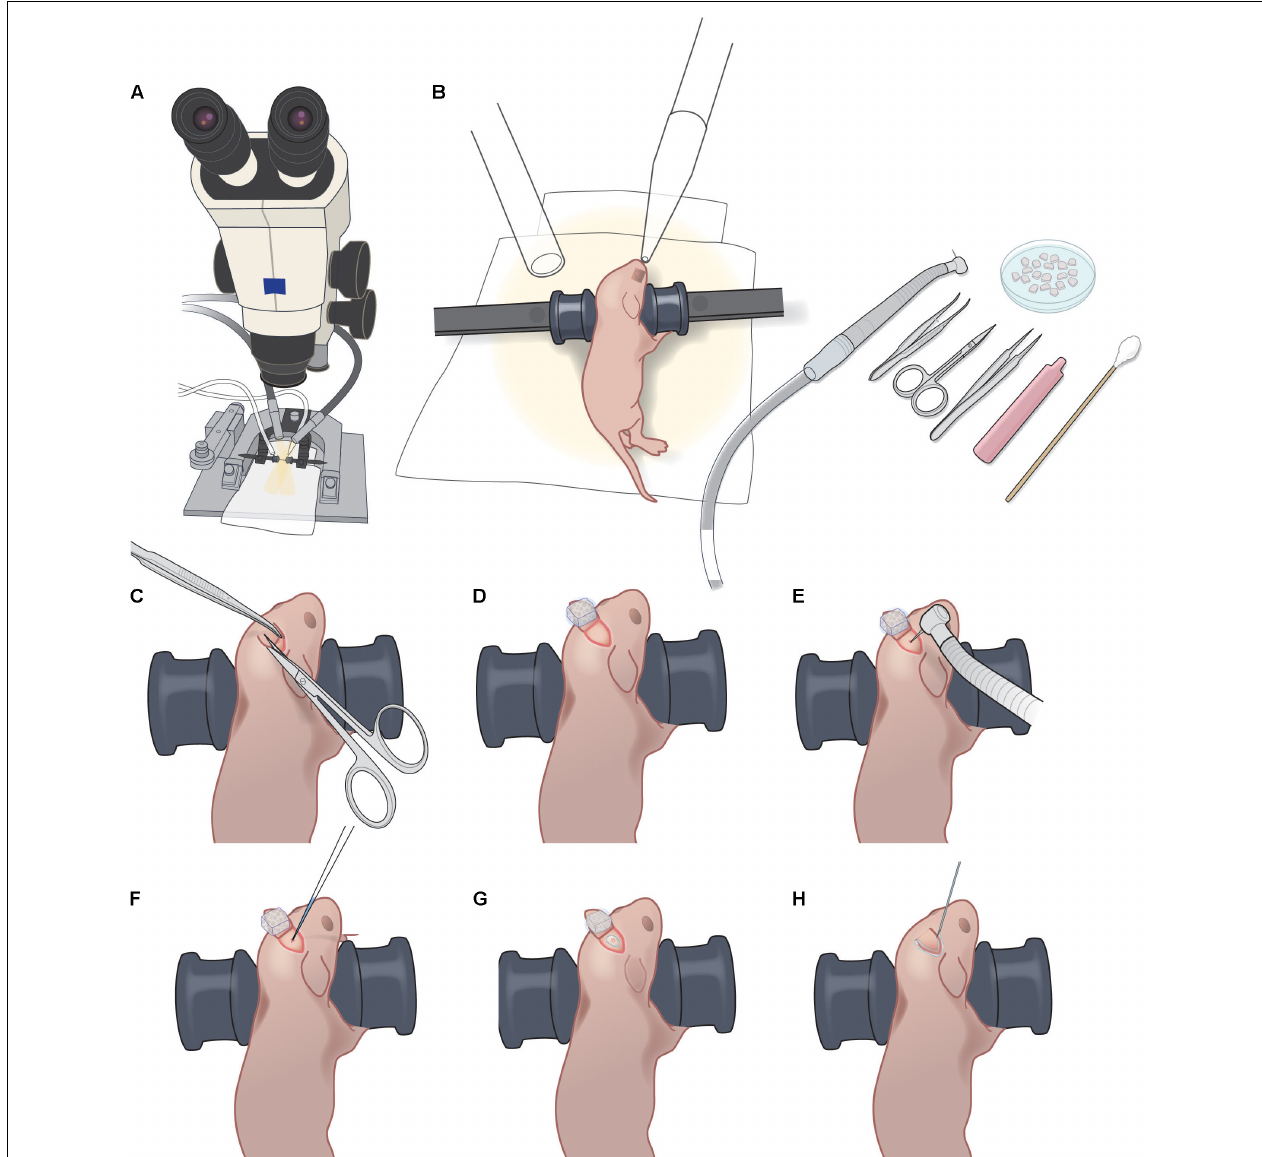
FIGURE 1 | P1 injection setup and procedure. (A) Dissecting microscope with goose-neck illumination. (B) Positioning of P1 pup with blunt ear bars, isoflurane delivery and exhaust tubes, pneumatic dental drill, forceps, iridectomy scissors, fine forceps, sterile saline vial, sterile cotton swab, and petri dish with Gelfoam sponges soaking in sterile saline. (C) . Creating a 3–4 mm triangular skin flap over the desired injection area. (D) Folding back the skin flap and covering with wet Gelfoam to prevent the skin flap from drying out. (E) Light drilling of exposed skull to crack the bone slightly. (F) Injection of rAAV-GCaMP with glass